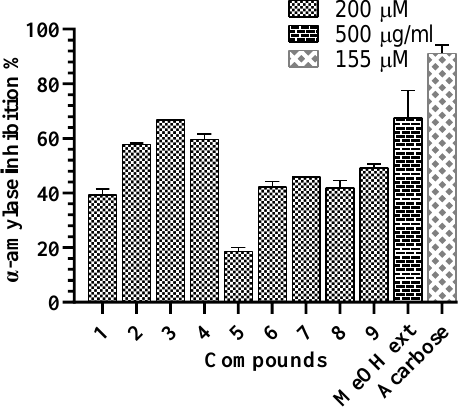
Figure 4. α -Amylase inhibitory effects of the G. sylvestre extract and compounds 1 – 9